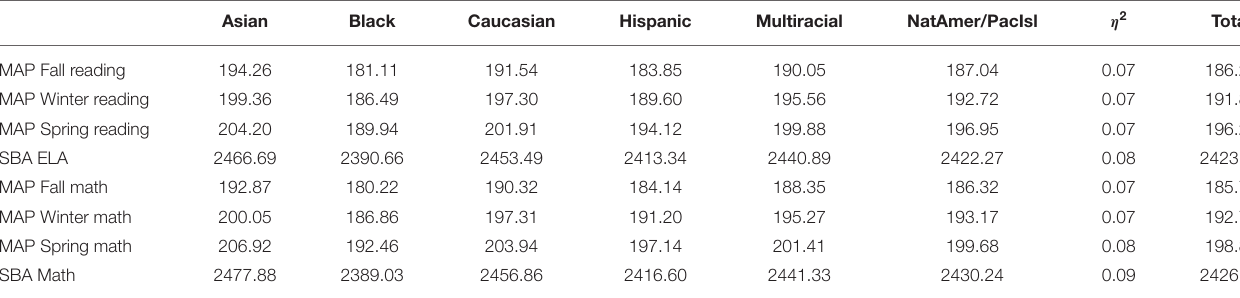
TABLE A2 | MAP and SBA means for the raw scores by Ethnicity